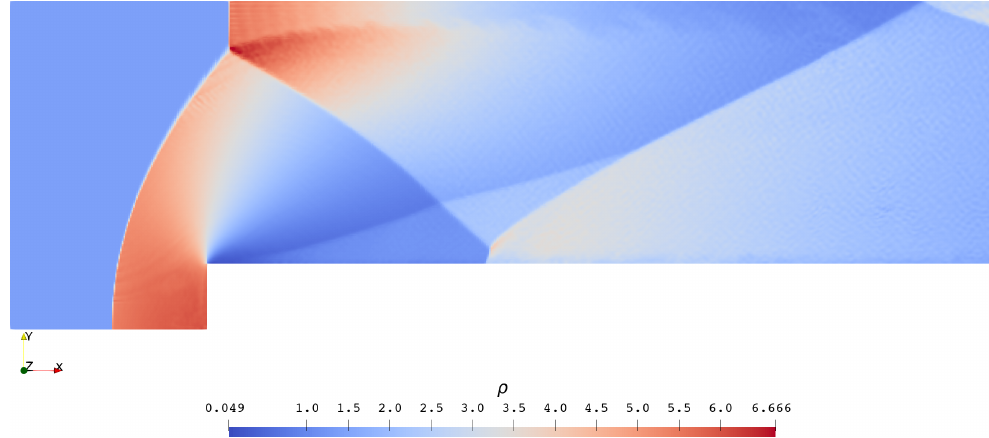
Figure 17. Third-order solution of Problem 4 at t = 2.8 on an h = 1/200